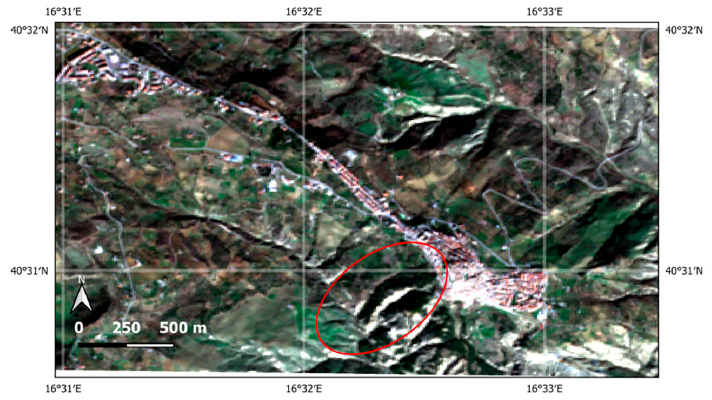
Figure 3. As Figure 2 for the Sentinel-2A image of 9th February 2018 at 09.40 GMT. To highlight the landslide footprint, the NDVI map difference between the two above-shown images has been computed and plotted in Figure 4, while the NDVI single maps are not reported for the sake of brevity. In Figure 4, brown tones indicate a decrease in NDVI values at different levels, while green ones are related to NDVI increases. It is worth noting that in this palette, the highest extreme values are indicative of a sharp land cover change between vegetated and not soils.